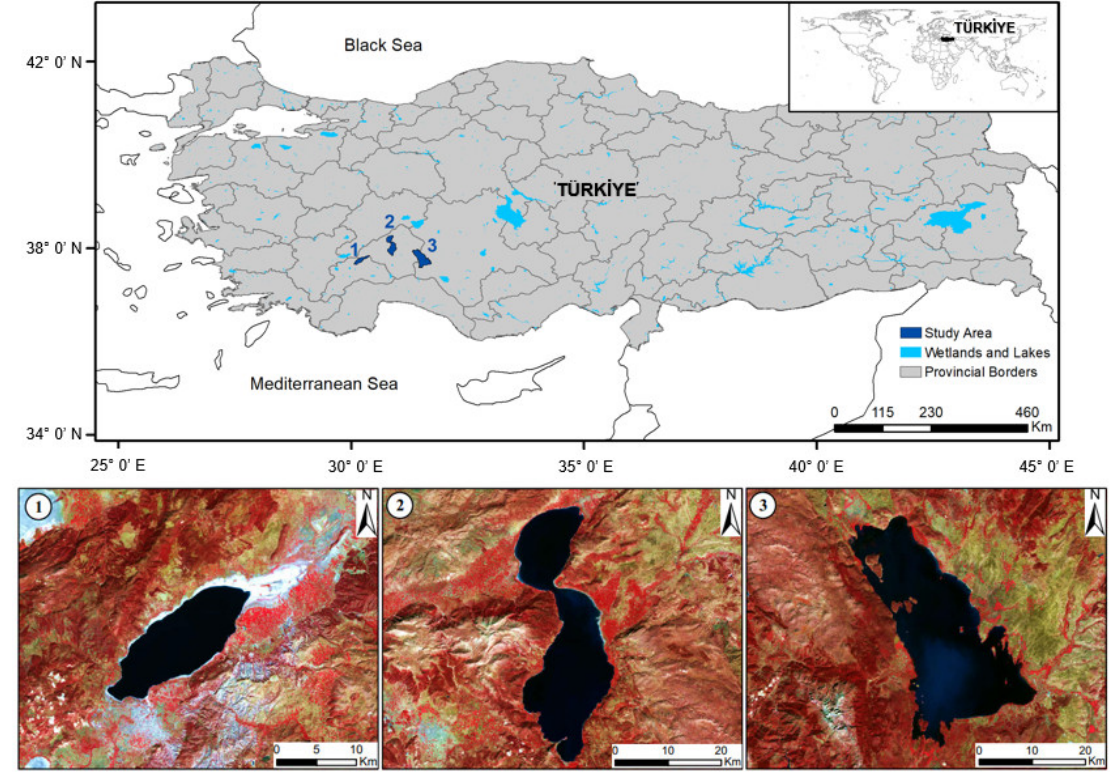
Figure 1. The location map of the study area, illustration of the test sites using false color (NIR-Red- Green) Landsat satellite data acquired in 2021: (1) Lake Burdur, (2) Lake Egirdir, and (3) Lake Beysehir.